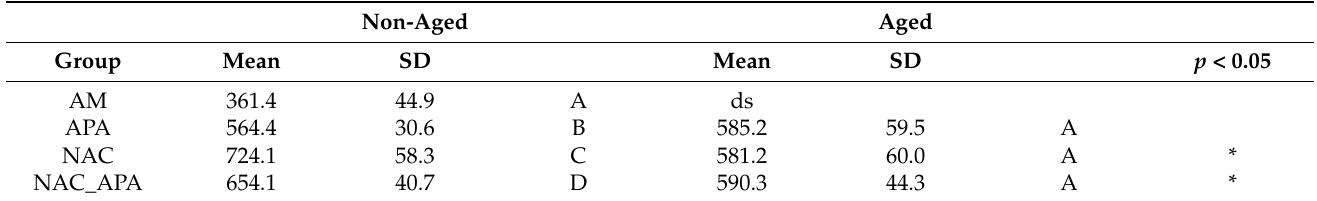
Table 1. Load-bearing capacity means and standard deviations (SD), in Newtons, of the experimental groups after quasi-static loading. The same upper-case letters in each column denote no statistical differences ( p < 0.05). * denotes statistically significant difference between LBC values of non-aged and aged subgroups of the same experimental group.